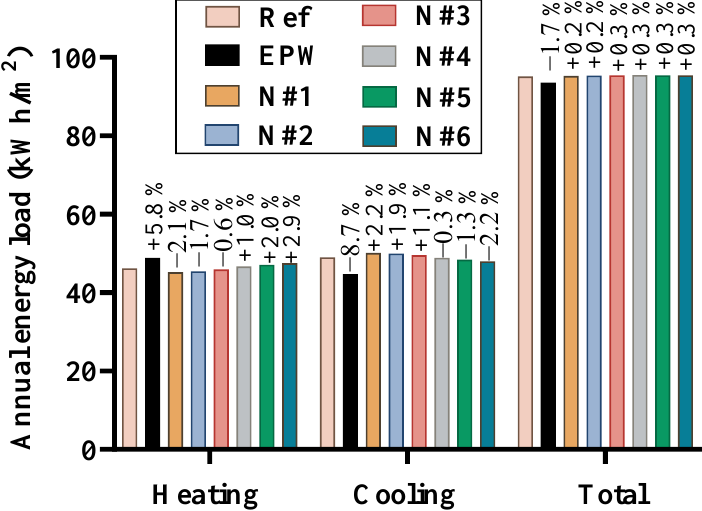
Figure 19. Annual loads of different heights for north orientation.